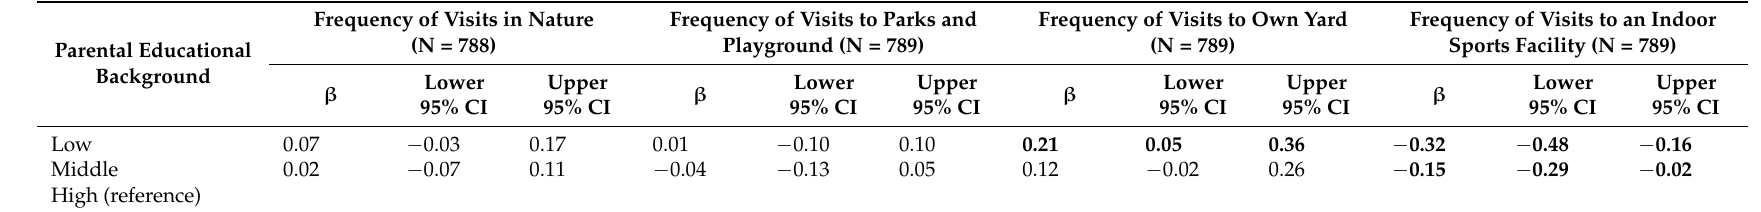
Table 3. The associations between parental educational background and co-participation in physical activity adjusted for gender of parental questionnaire respondent, measurement season, and child’s gender and age